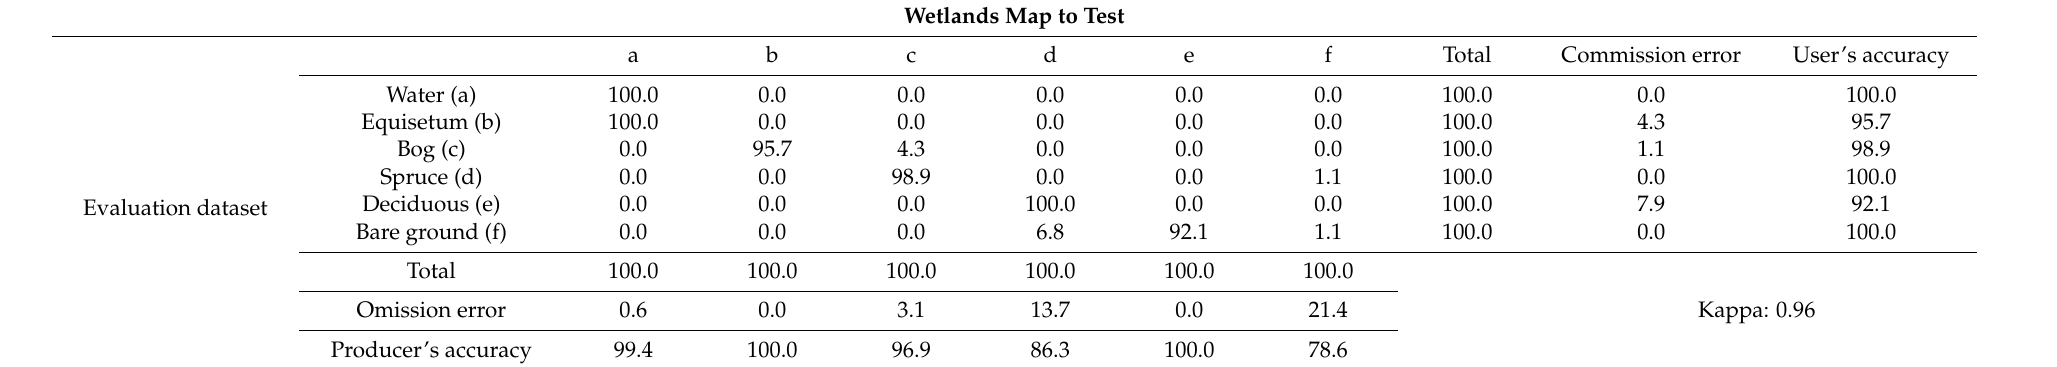
Table 4. Confusion matrix for area B maximum likelihood classification. Results in